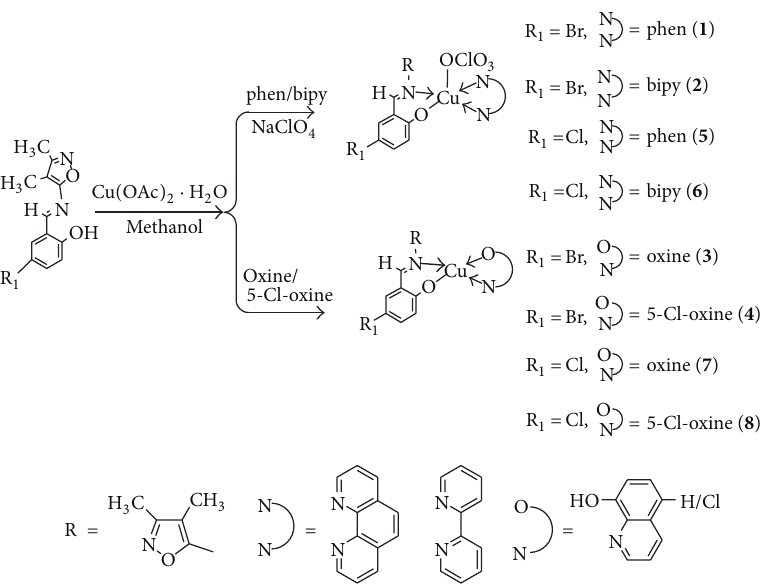
Scheme 1: Schematic routes of the synthesis of the complexes.